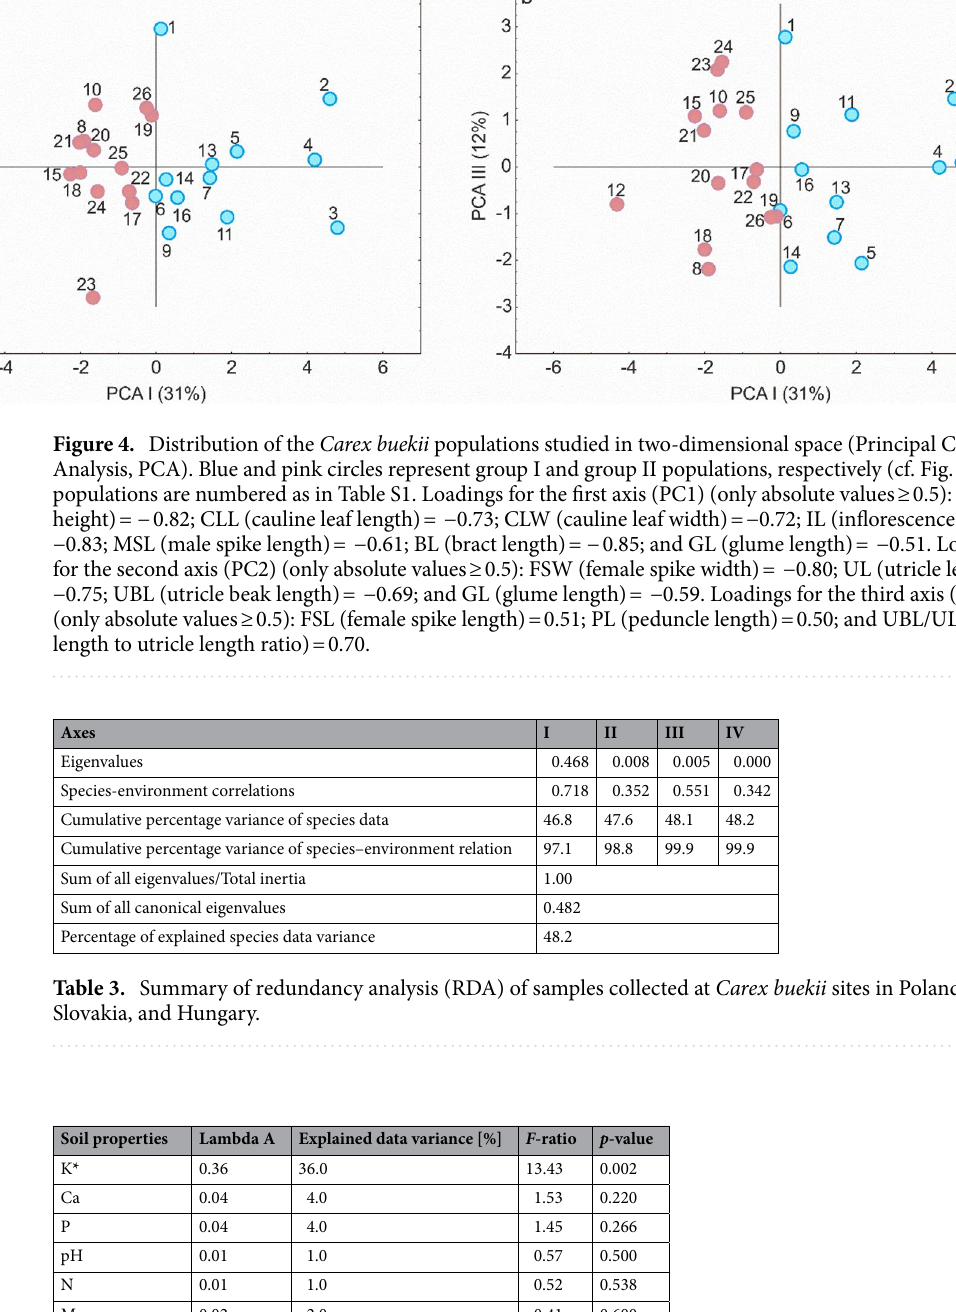
Table 4. Forward selection results with test of variable significance for samples collected at Carex buekii sites in Poland, Slovakia, and Hungary. *Variables statistically significant (p ≤ 0.05).